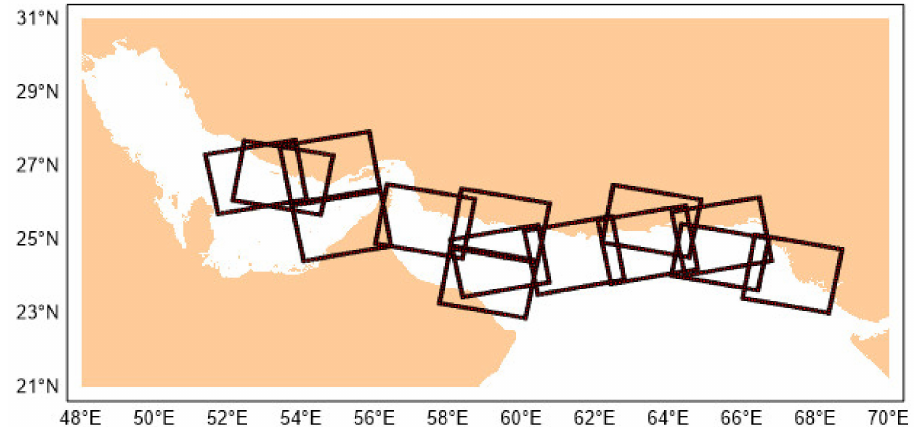
Figure 2. SAR distribution in the Hormuz Strait.